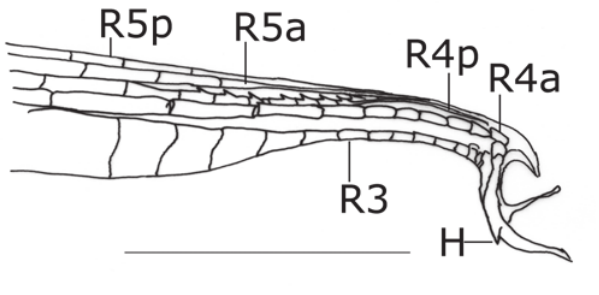
Fig. 35. Gonopodium tip of Phalloceros malabarbai , holo- type, MZUSP 79669. R3, R4a, R4p, R5a, R5p indicate gonopodial rays. H = hook. Scale bar 1